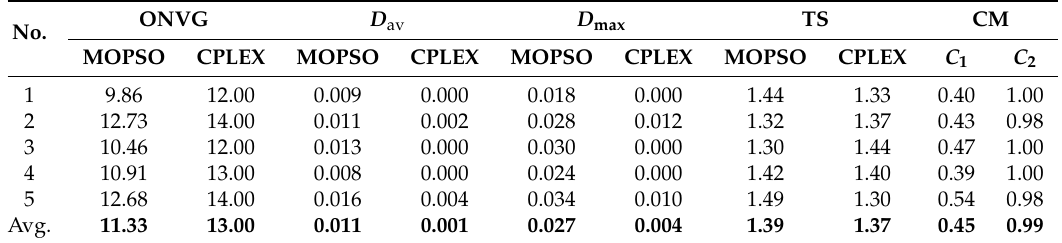
Table 3. Comparison between MOPSO and CPLEX (with weighted sum method) based on the instances with ( n , E , L ) = ( 50,3,10 )